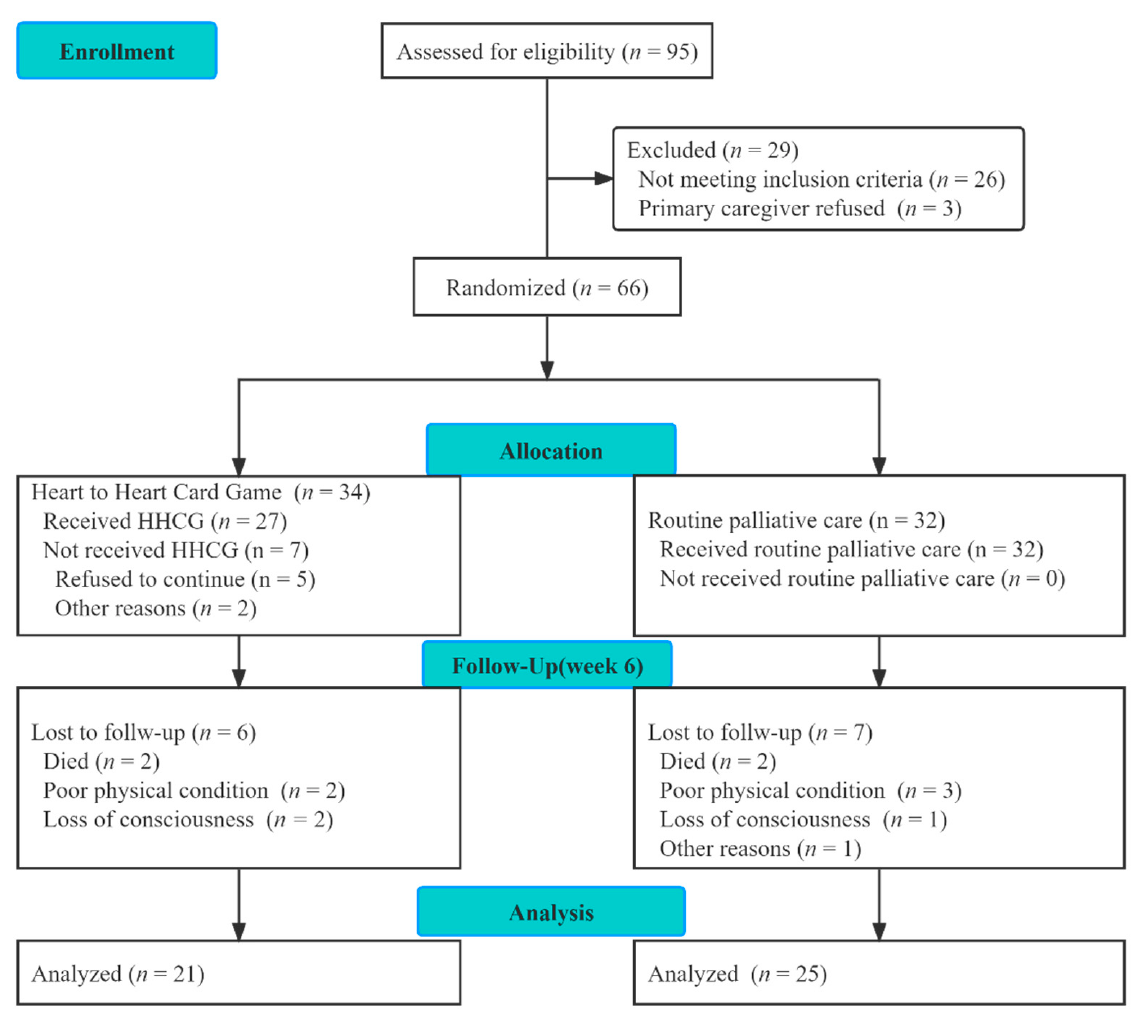
Figure 1. Participant flowchart of the RCT.